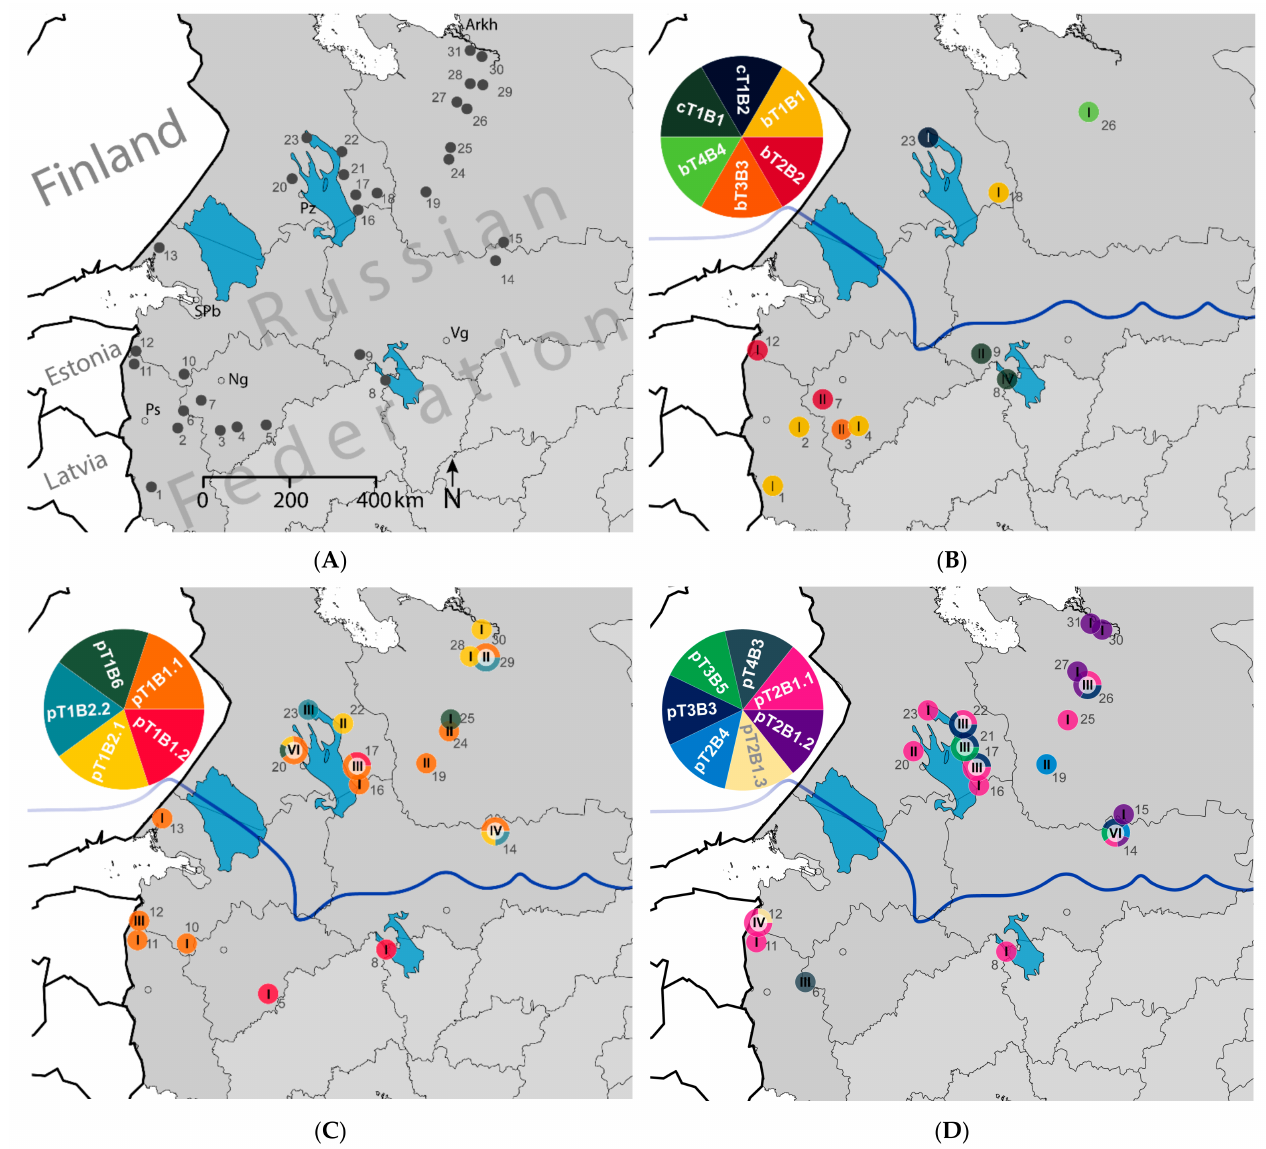
Figure 2. Distribution of Beauveria spp. And haplotypes across northern European Russia. ( A ) Geographical map and specimens’ locations numbered with respect to Table S1. Abbreviations: Arkh—Arkhangelsk, Vg—Vologda, Ng—Novgorod, Ps—Pskov, SPb—St. Petersburg, Pz—Petrozavodsk. ( B ) Distribution of B. bassiana (bT1B1 to bT4B4) and B. caledonica (cT1B1 to cT1B2) haplotypes. ( C ) Distribution of B. pseudobassiana haplotypes (pT1B1.1 topT1B6). ( D ) Distribution of B. pseudobassiana haplotypes (pT2B1.1 to pT4B3). The haplotypes’ designations are derived from Figure 1. Roman numerals correspond to isolating the quantity at that location. The blue line indicates the boundary between the southern and northern climate zones (dfb and dfc) according to the Köppen-Geiger climate